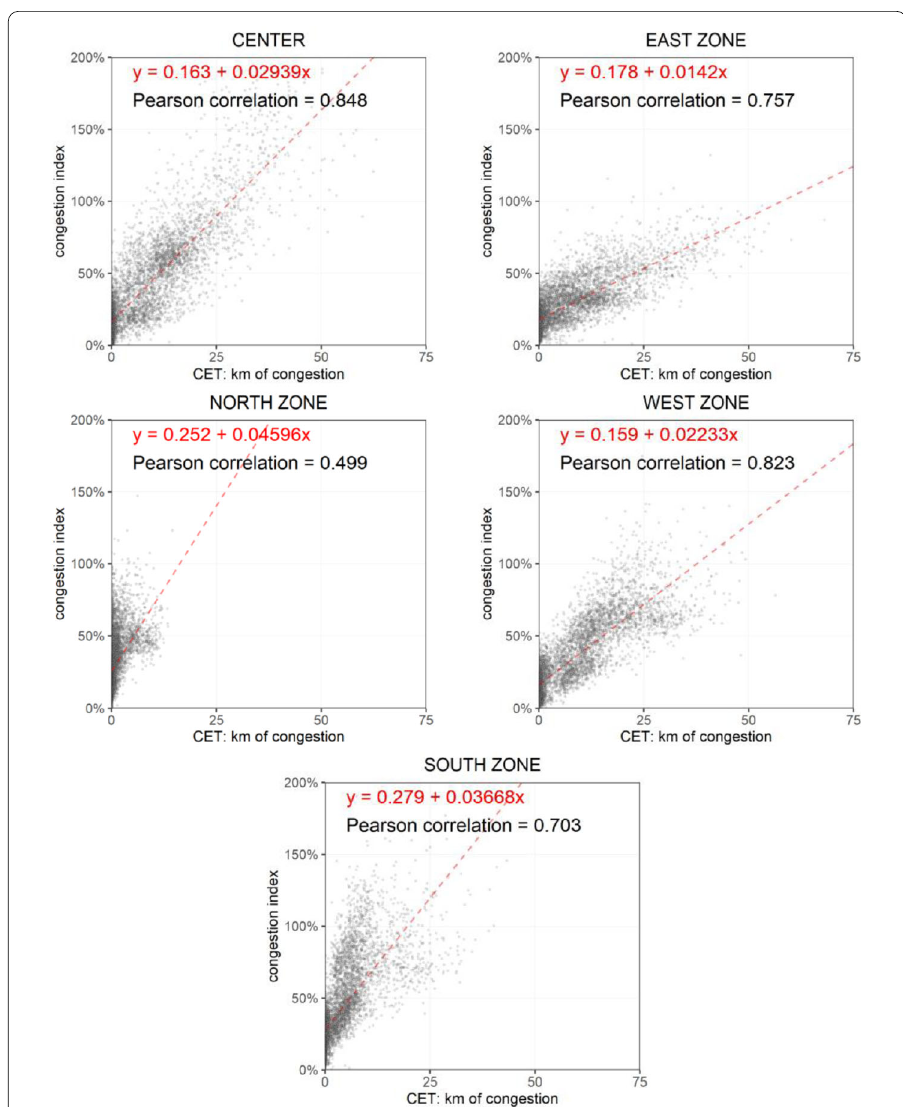
Figure 6 Dispersion graph—congestion index and kilometers of slowdown by region of the city of São Paulo. Each point represents the value of both variables for the period of a day observed between 2016–2018. The dashed red line is the prediction of the bivariate model that estimates the congestion index based on the kilometers of slowness plus an intercept